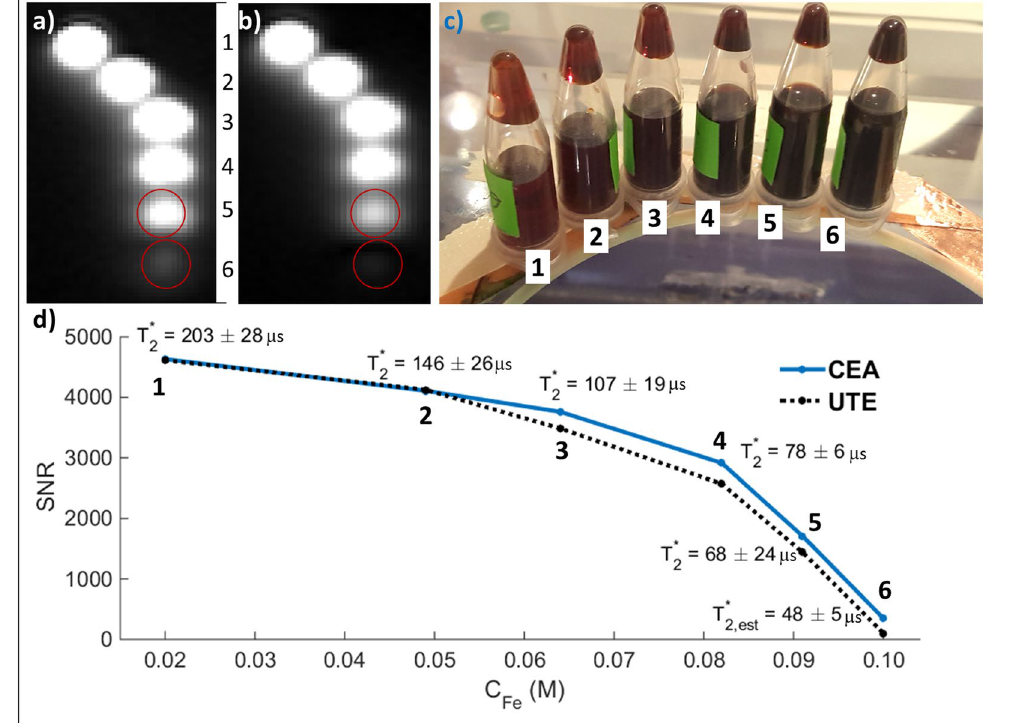
Figure 7. Comparison of CEA and UTE in MRI of iron-oxide solutions. A coronal slice from the images acquired with ( a ) CEA and b) UTE. ( c ) A photo of the iron-oxide phantoms with different concentrations placed on the CEA coil form, which is made of glass. ( d ) SNR comparison for various Fe concentrations and T 2 * values measured using the UTE sequence. The last T 2 * value, i.e., for phantom 6, was estimated by assuming linear dependence of 1/T 2 * on C Fe